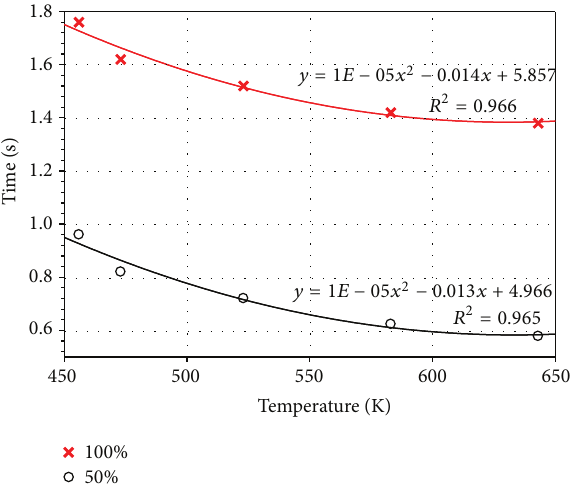
Figure 12: Filling times at 50% and 100%